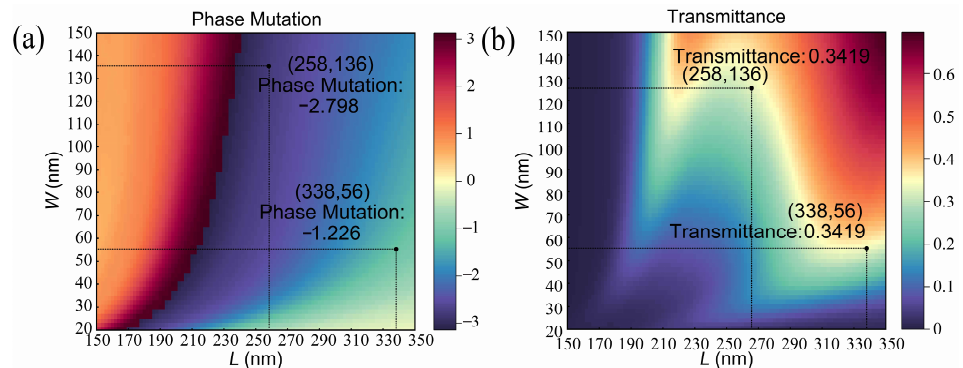
Figure 3. Simulated optical properties of a single rectangular slot. ( a ) Phase mutation of the rectangular slots corresponding to different length (150–350 nm) and width (20–150 nm) ranges at a wavelength of 532 nm and an aluminum film thickness of 200 nm. ( b ) Transmittance of the rectangular slots corresponding to different length (150–350 nm) and width (20–150 nm) ranges at a wavelength of 532 nm and an aluminum film thickness of 200 nm. The Jones matrix of the quarter ‐ wave plate with zero azimuth is: